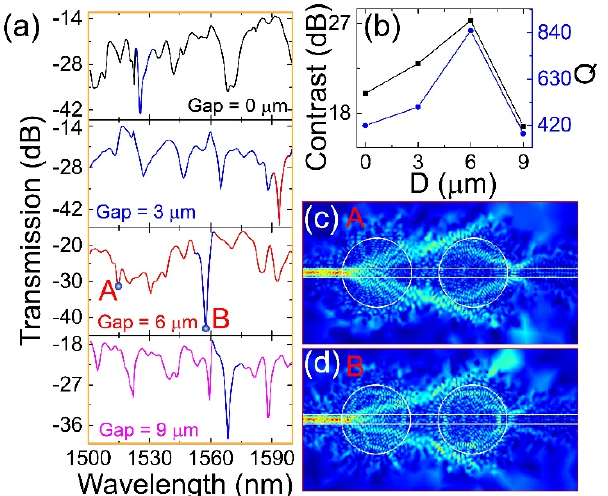
Figure 3. ( a ) The transmission spectra of silica taper-assisted two microspheres with the equal diameter of 15 µm under different gap in between. ( b ) The corresponding comparisons of the contrast and quality factor under different gap. ( c , d ) Electric field distributions at point A and point B in Figure 3a.